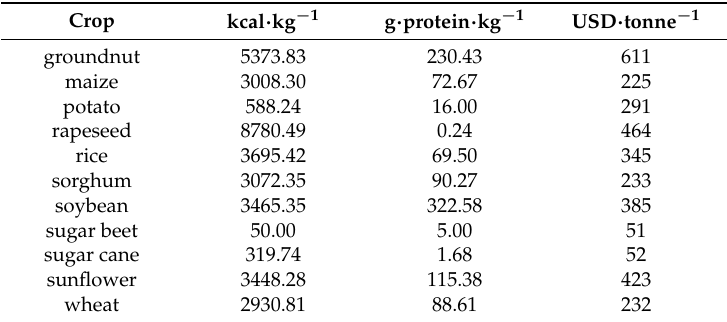
Table 1. Crop-specific conversion factors for calories, protein, and price.